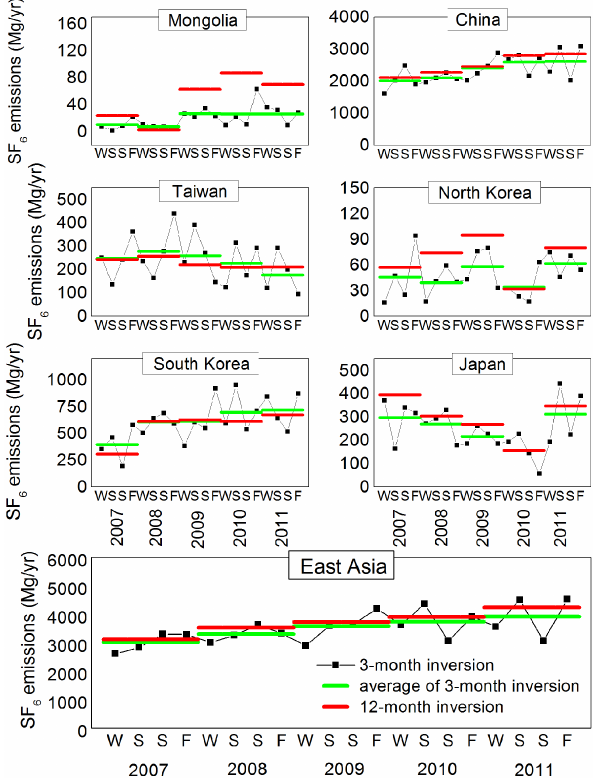
Fig. 5. Seasonal variations of SF 6 a posteriori emissions for each East Asian country for the 2007–2011 period. Black dots denote a posteriori emissions from seasonal inversions; green lines denote an average of a posteriori emissions from four seasonal inversions in each year; red lines denote a posteriori emissions from the refer- ence inversion using the whole-year observation data. W, S, S and F on the x axis represent winter (December, January, and February), spring (March, April, and May), summer (June, July and August) and fall (September, October and November) in each year, respec-